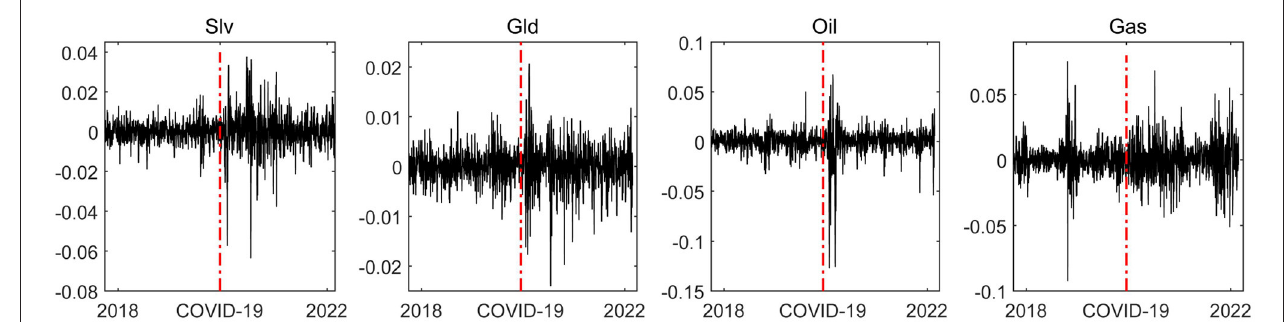
FIGURE 1 | Volatility of compound return sequences of commodity prices. Black solid line represents the dynamic change of compound returns of commodity prices; the red dash line represents the starting point of the COVID-19 epidemic, and the starting date of the COVID-19 epidemic data at Johns Hopkins University is used as the outbreak date of the COVID-19 epidemic in this paper.